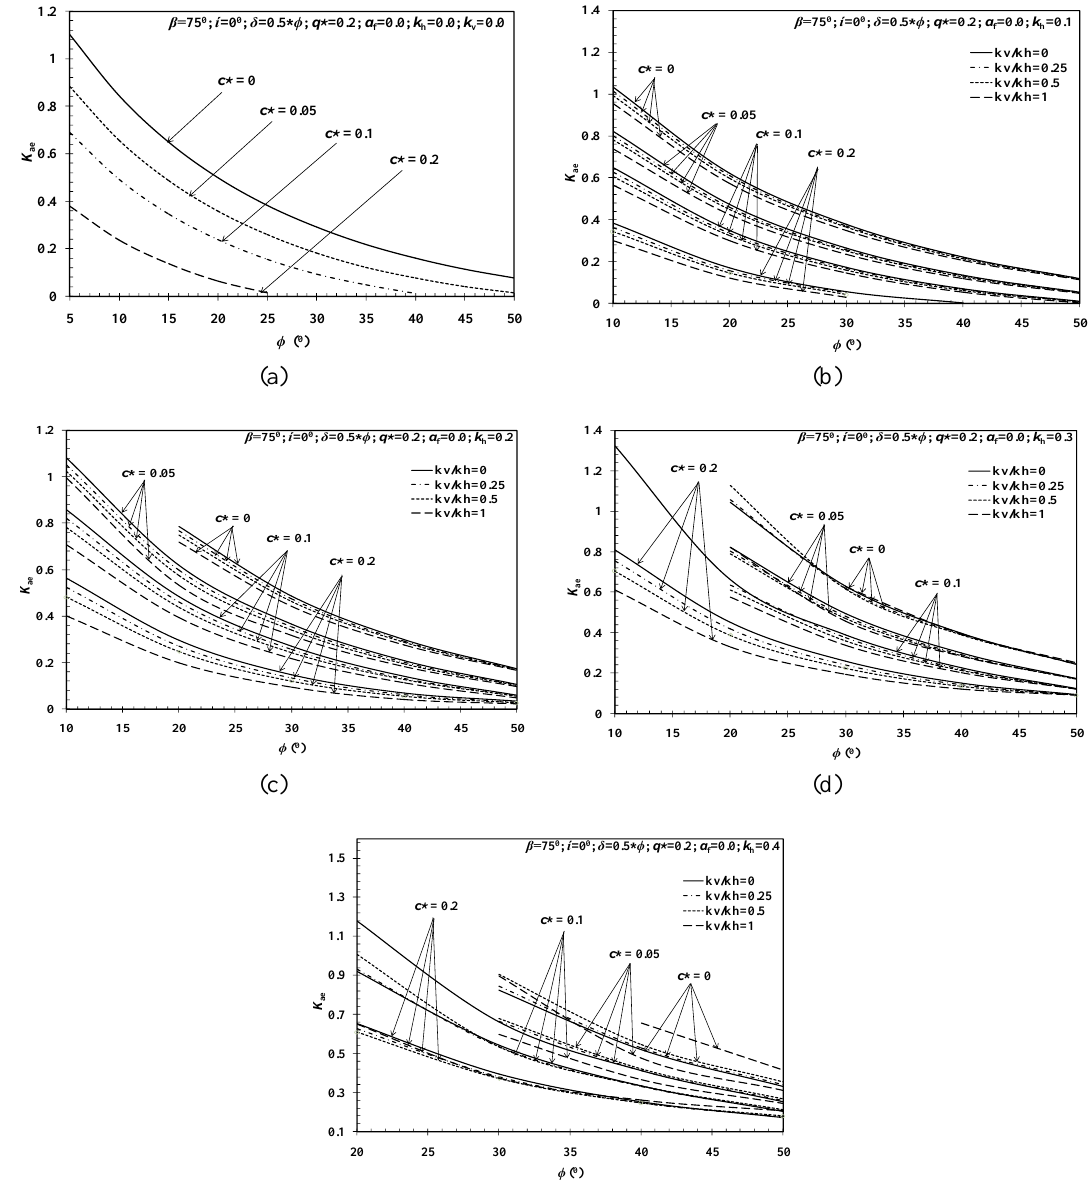
Figure 1. Design charts for K ae for backfill slope i = 0 o and wall inclination β = 75 o